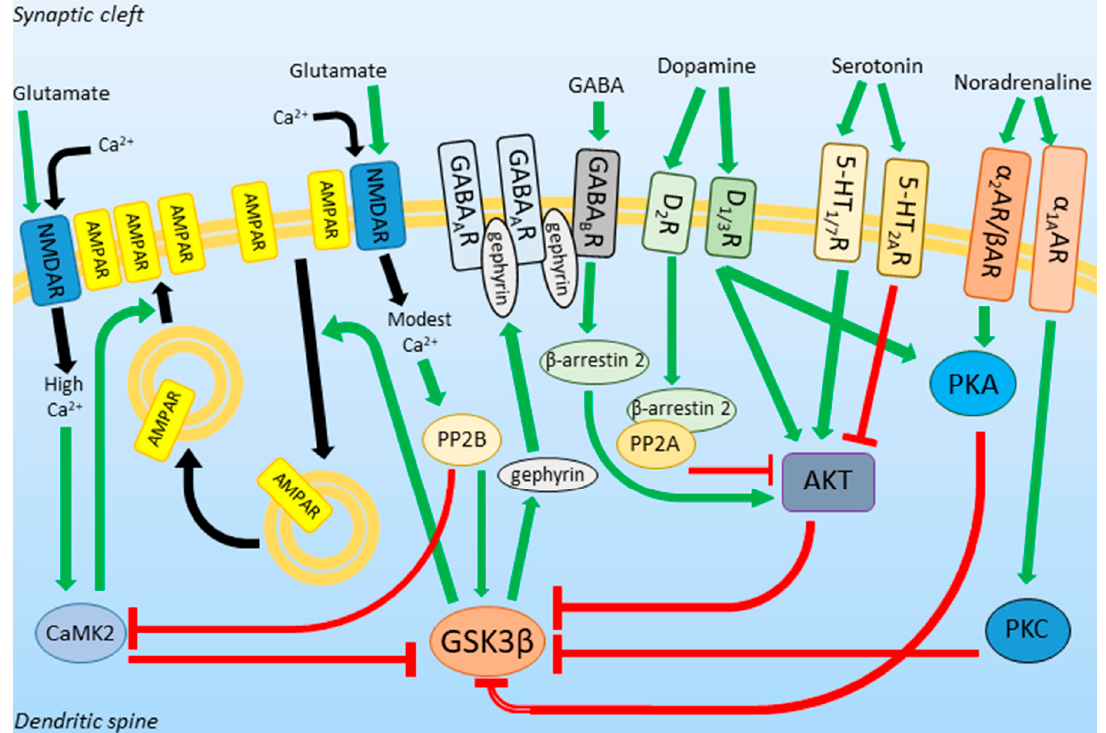
Figure 1. Neurotransmitters acting through protein kinases and phosphatases regulate glycogen synthase kinase 3 β (GSK3 β ) activity. GSK3 β influences the strength of excitatory and inhibitory synapses. Green arrows represent activation, red arrows represent inhibition, black arrows represent translocation. Abbreviations: NMDAR: N -methyl- D -aspartate receptor, AMPAR: α -amino-3-hydroxy-5-methyl-4-izoxazole propionic acid receptor, GABA B R: γ -aminobutyric acid receptor type B, D 1/2/3 R: dopamine receptors, 5-HT 1/2A/7 R: serotonin receptors, α 1A / α 2 / β AR: adrenergic receptors, PKA: protein kinase A, AKT: protein kinase B, PKC: protein kinase C, PP2A/2B: protein phosphatases 2A/2B, CaMK2: calcium/calmodulin dependent protein kinase 2, GSK3 β : glycogen synthase kinase 3 β .